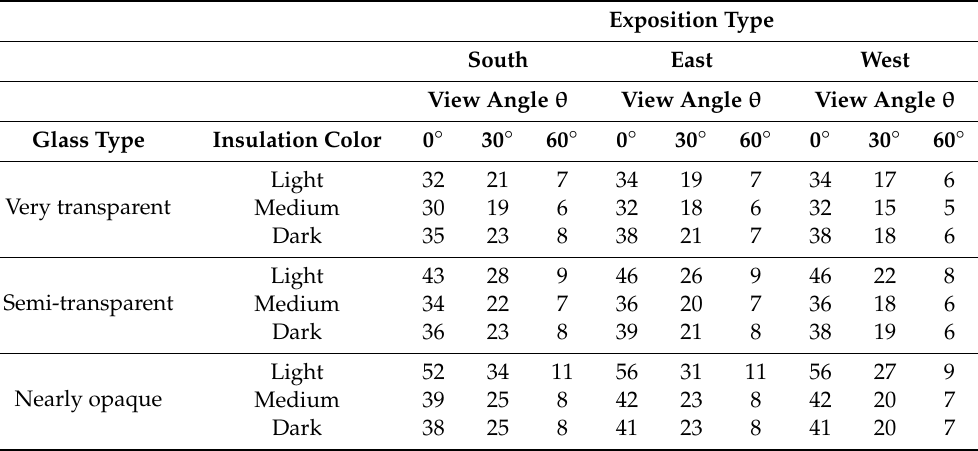
Table 8. Maximum thermal stresses (MPa) for